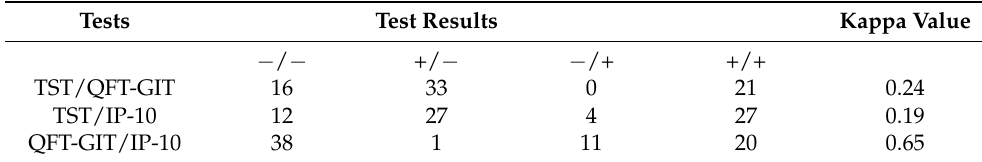
Table 3. Concordance among latent tuberculosis infection